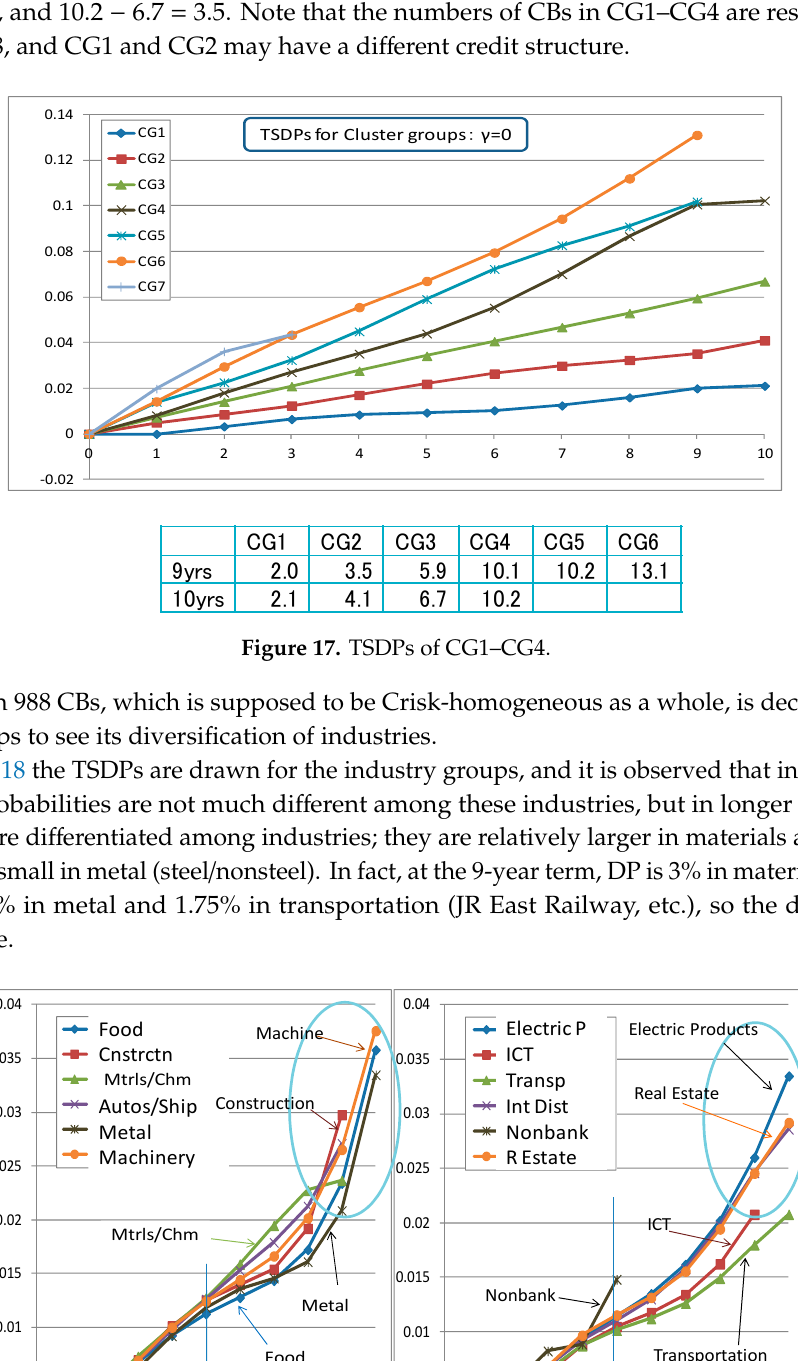
Figure 18. TSDPs of industry groups in CG1. Mtrls/Chm, materials/chemicals; Cnstrctn, construction; Int Dist, international distribution (trading).